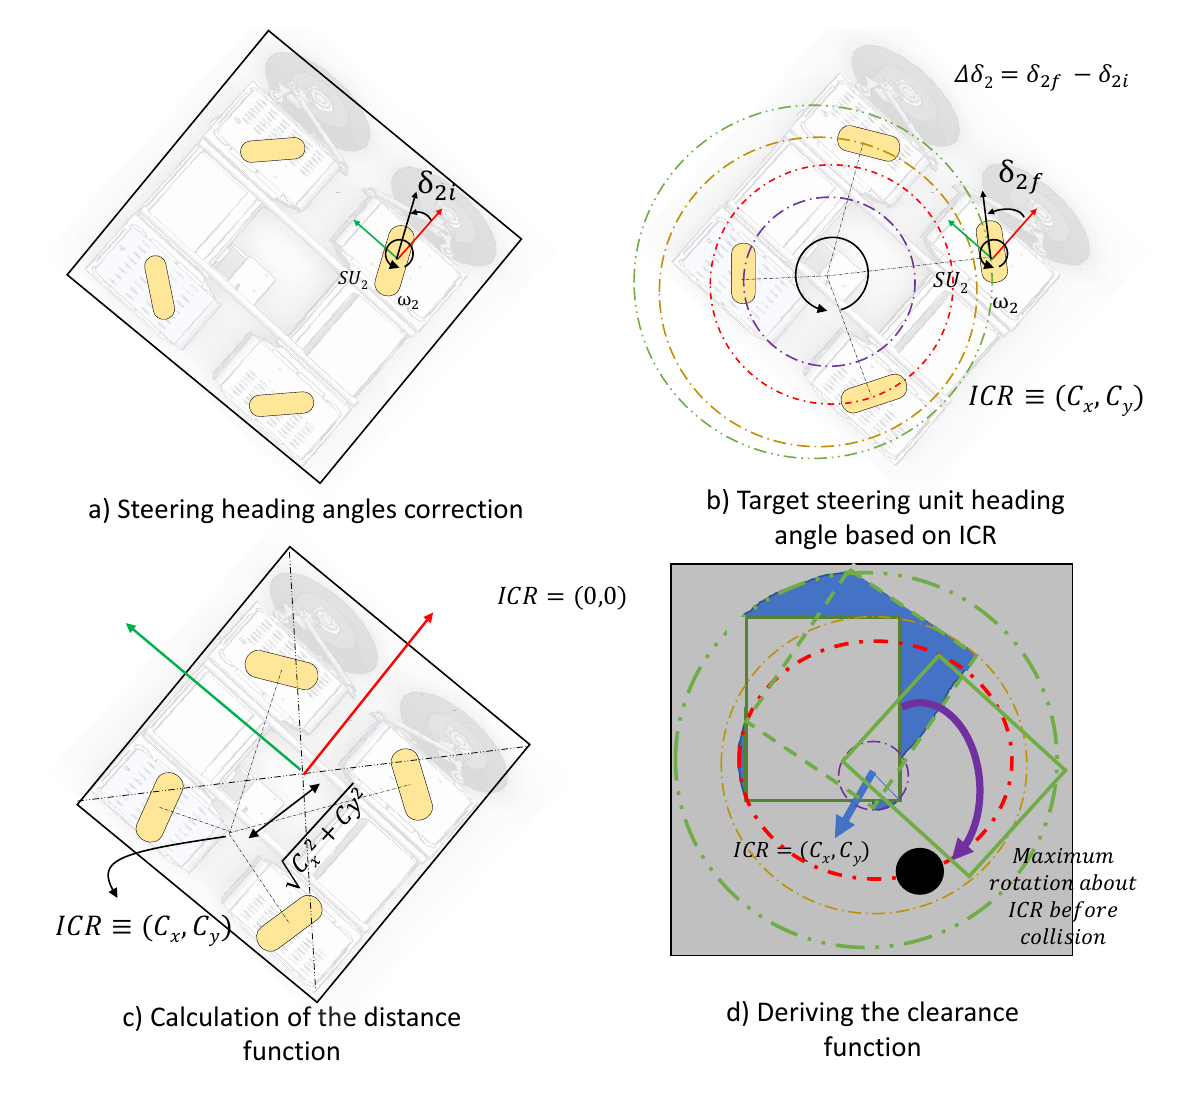
Figure 7. Visualisation of the objective